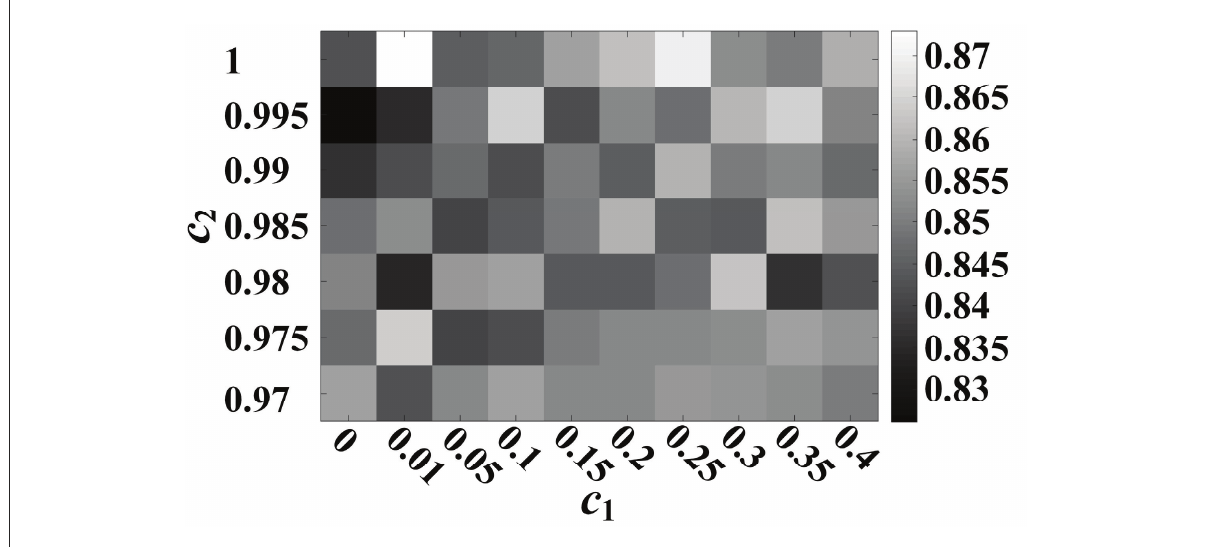
FIGURE13 Effect of c 1 and c 2 parameters of the transition model on the 10-fold cross-validated accuracy of MA vs. MS for all